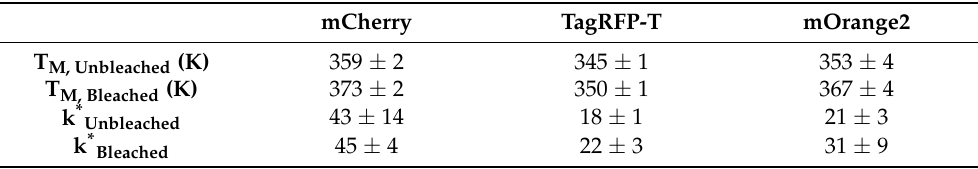
Table 1. The melting temperature for all samples was determined by the midpoint in the drop-off of far-UV CD signal at 218 nm. The effective force constant k * is calculated for low temperature regime (100–200 K) at 1.0 THz, while other frequencies show similar